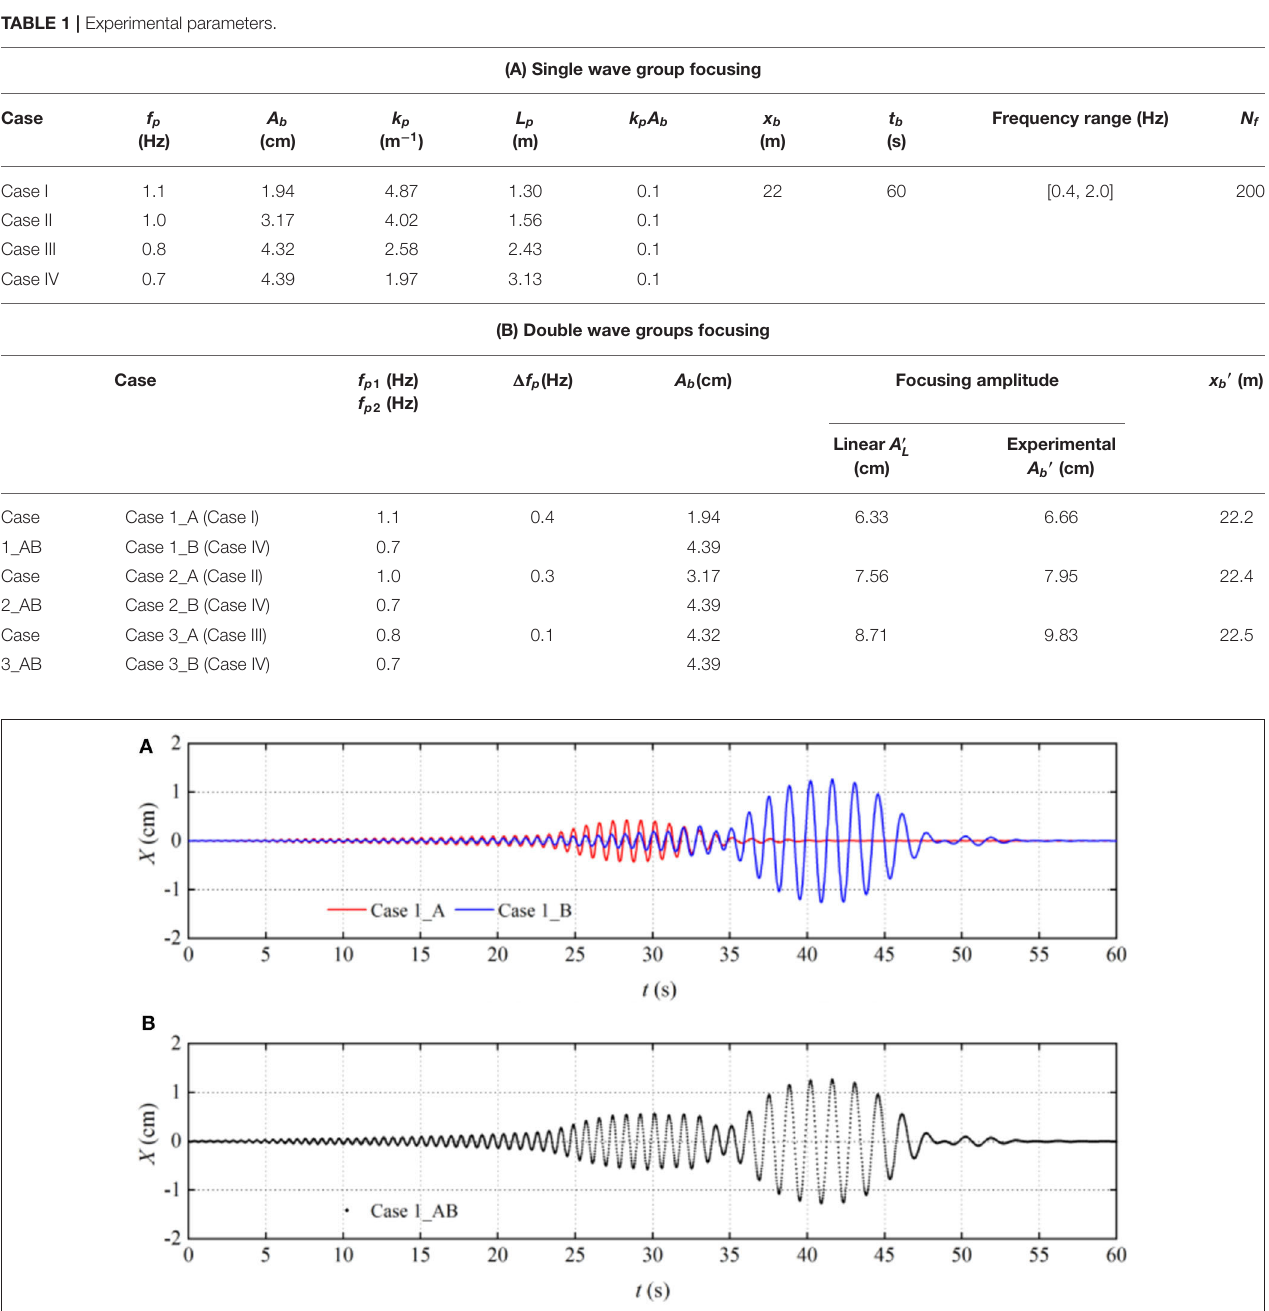
TABLE 1 | Experimental parameters.